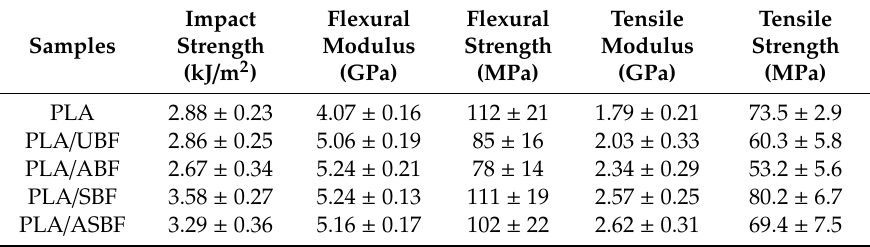
Table 8. Mechanical properties of PLA / BF composites modified by various